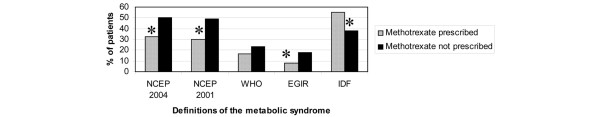
The relationship between methotrexate use and the presence of the metabolic syndrome according to the definition used. * P < 0.05. EGIR = European Group Against Insulin Resistance; IDF = International Diabetes federation; NCEP = National Cholesterol Education Programme; WHO = World Health Organisation.